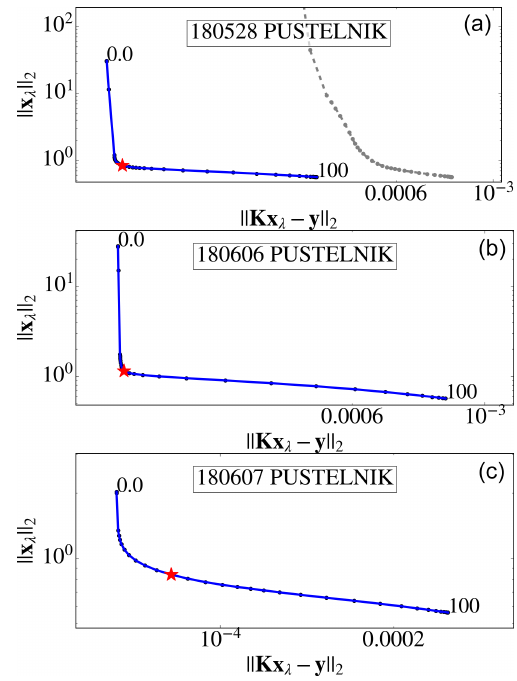
Figure 9. The L-curves for the three Pustelnik (S) case studies. Panel (a) additionally depicts the L-curve of the same case study (dashed grey line) but under consideration of the full data set in- cluding the morning and afternoon hours, which suffered from for- ward model errors and are omitted in the final analysis (blue curve). The regularization parameters, λ , range from 0 to 100. The red star marker depicts the respective λ used for the emission